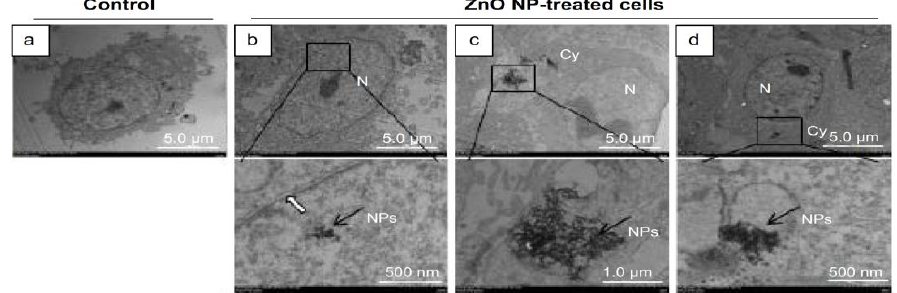
Figure 23. Viability of ( a ) Leydic cells and ( b ) Sertoli cells treated with ZnO NPs of various concentrations for 12 and 24 h as determined with MTT cell proliferation assay. LDH leakage level of ( c ) Leydic cells and ( d ) Sertoli cells. Data are presented as mean ± standard deviation of three separate experiments, in triplicate. * p < 0.05, ** p < 0.01. Reproduced from [143] under the Creative Commons Attribution – Non Commercial (unported, v3.0) license.